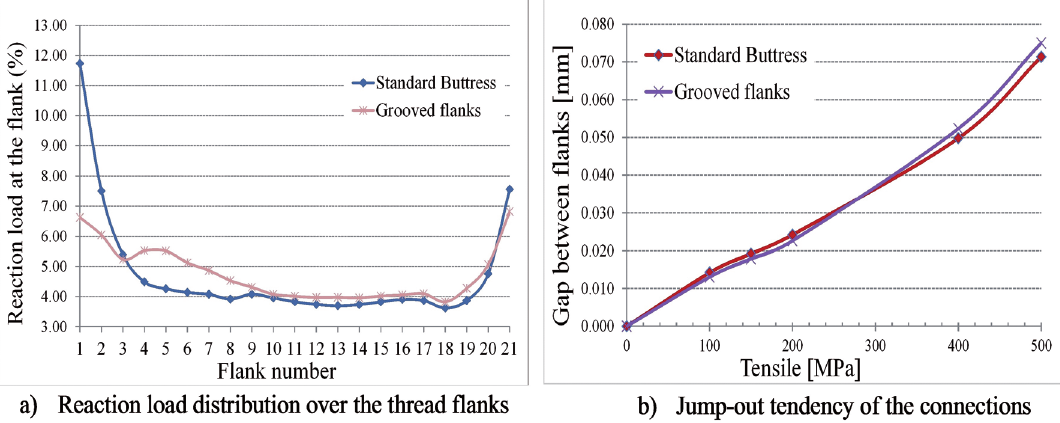
Figure 11: Results of reaction load distribution and jump-out of the modified (grooved) connection compared to the standard API Buttress connection. Boundary conditions: a) maximum make-up torque plus 200MPa tensile stress; b) maximum make-up torque plus crescent tensile